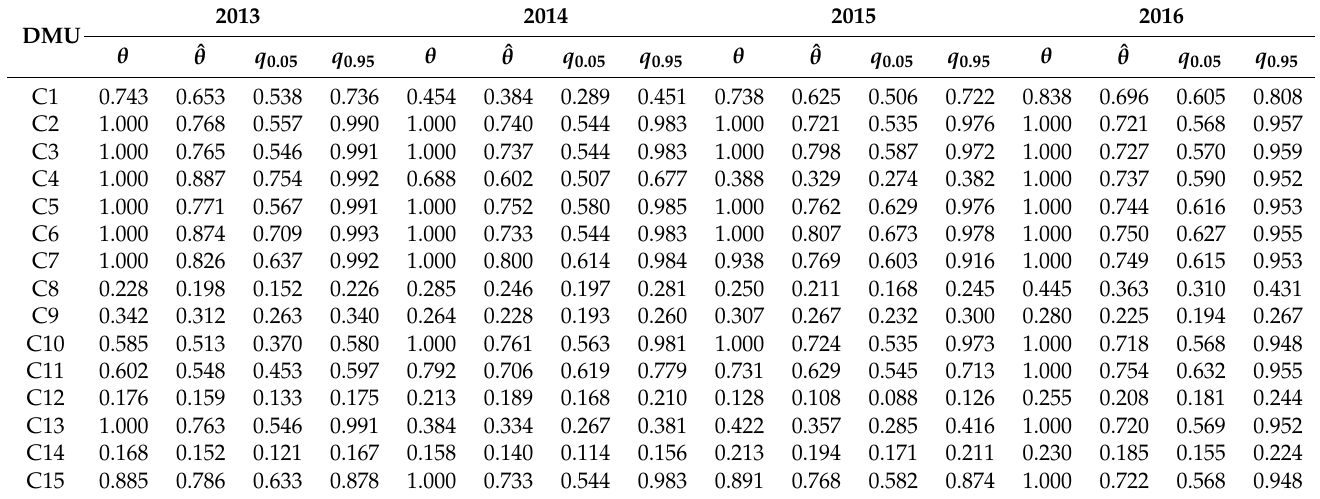
Table 3. Planning dimension efficiencies, bias-corrected bootstrap efficiencies, and quantiles.